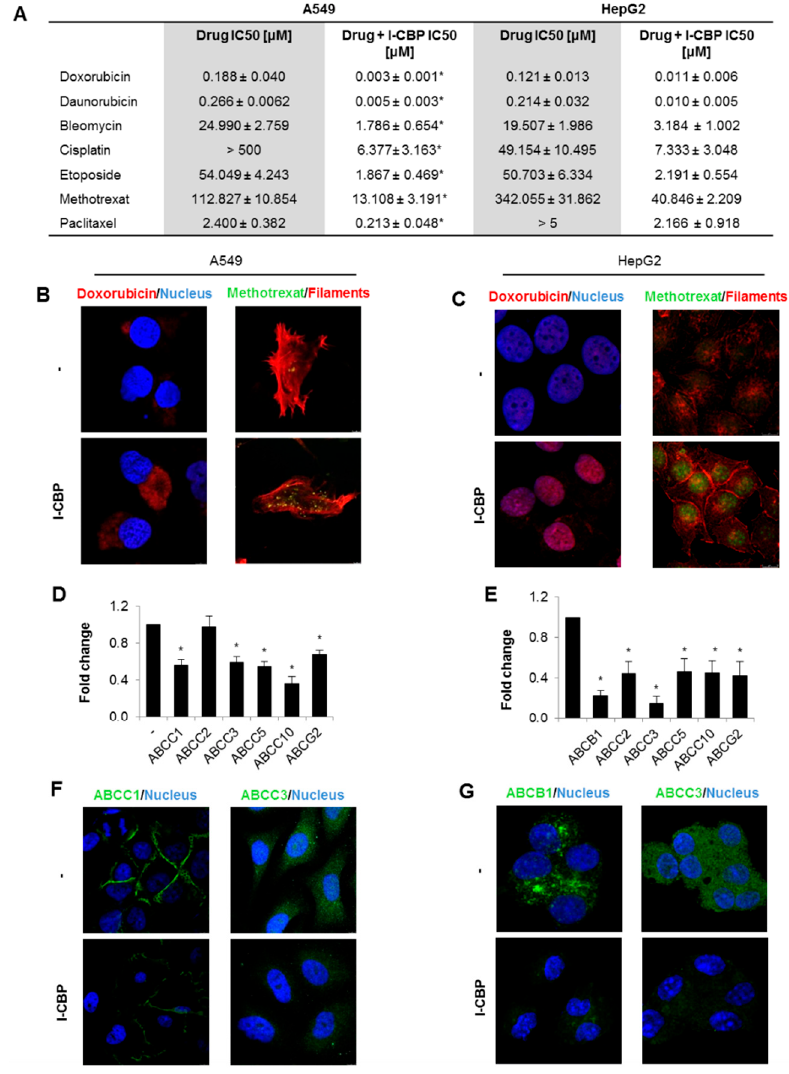
Figure 4. I-CBP112 sensitized other cancer cell types to chemotherapeutics, increased drug accu- mulation in cells, and reduced expression of ABC transporters. ( A ) IC50s were evaluated in another two cell lines—A549 lung cells and HepG2 hepatocytes—with the resazurin toxicity assay. Cells were incubated with 10 µM I-CBP112 for 72 h prior to the administration of drugs for another 48 h. IC50 was determined from the binominal equation (Supplementary Statistics: resazurin A549 and resazurin HepG2). The autofluorescence of doxorubicin and methotrexate was imaged in control and I-CBP112 (10 µM; 72 h)-pretreated A549 ( B ) and HepG2 ( C ) cells using a confocal microscope. Doxorubicin-treated cells (0.5 µM; 24 h) were additionally stained with DAPI (blue, nucleus), whereas methotrexate-treated (5 µM; 24 h) cells were additionally stained with phalloidin-Texas Red (red, actin filaments). ( D , E ) The impact of I-CBP112 (10 µM; 72 h) on ABC gene expression was measured by real-time PCR in A549 (D) and HepG2 ( E ) cell lines. The mRNA levels of particular genes were normalized to ACTB and GAPDH and assumed to be 1 for control cells. ( F , G ) Example of confocal images of ABC proteins that are highly abundant in A549 ( F ) and HepG2 ( G ) cells. I-CBP112 (10 µM) was added for 72 h. Transporters were stained in green (secondary anti-rabbit AlexaFluor488-conjugated antibody), and nuclei, in blue (DAPI). ( A , D , E ) bars represent the mean ± standard error of the mean (SEM). ( A ) IC50 values for the control and I-CBP112-treated cells were compared using Student’s t -test, and statistically significant differences between means are marked with * when p < 0.05. The same analysis was used to compare relative mRNA levels in ( D , E ). The preincubation of both cell lines with I-CBP112 for 48 h considerably affected IC50 values for all the tested chemotherapeutics from 8.6-fold to 78.2-fold in the culture